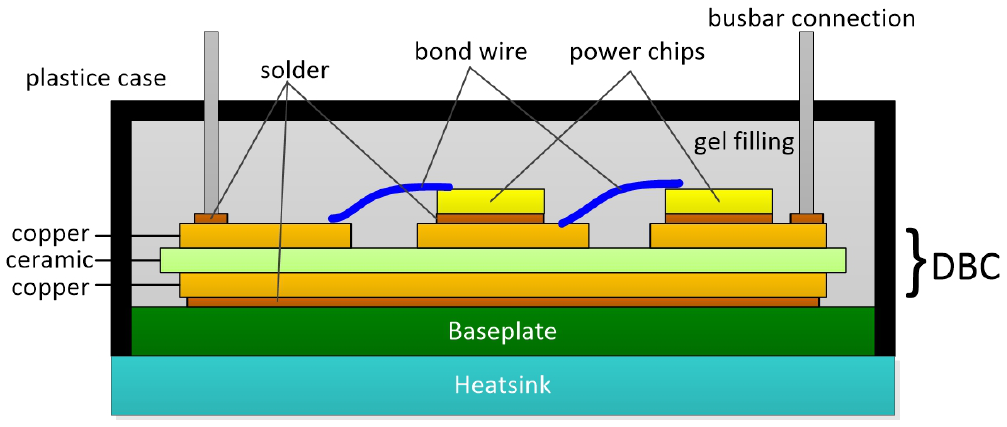
Figure 1. The structure of an IGBT module